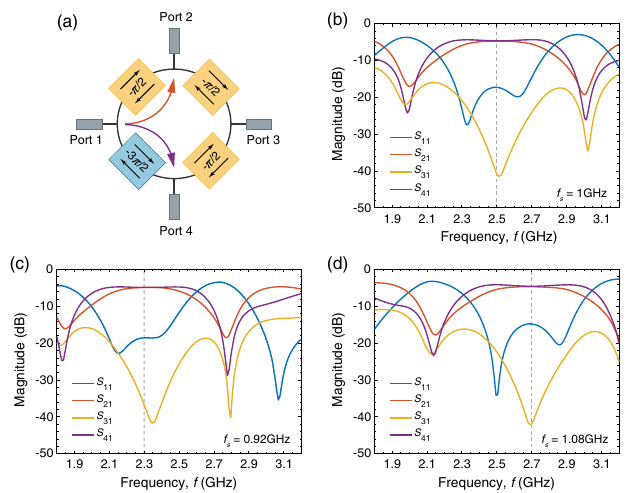
FIG. 8. (a) Schematic of a rat-race coupler aimed at f 0 ¼ 2 . 5 GHz, comprised of four commutated networks as in ¼ 1 GHz, C ¼ 0 . 47 pF, and L ¼ 1 nH, Fig. 1, with N ¼ 16 , f s connected in a ring. Three of the four sections are configured to provide a reciprocal phase shift ϕ 21 ¼ ϕ 12 ¼ − π = 2 at f ¼ f 0 by = 2 ( γ ¼ − π ). The fourth choosing the switching delay Δ T ¼ T s = 10 ( γ ¼ − 3 π = 5 ), leading to ϕ 21 ¼ ϕ 12 ¼ section has Δ T ¼ 3 T s − 3 π = 2 at f ¼ f 0 . (b) Corresponding scattering parameters computed using the numerical approach described in the Ap- ¼ 0 . 92 GHz and pendix. (c),(d) Scattering parameters for f s ¼ 1 . 08 GHz, respectively, with all other parameters un- f s